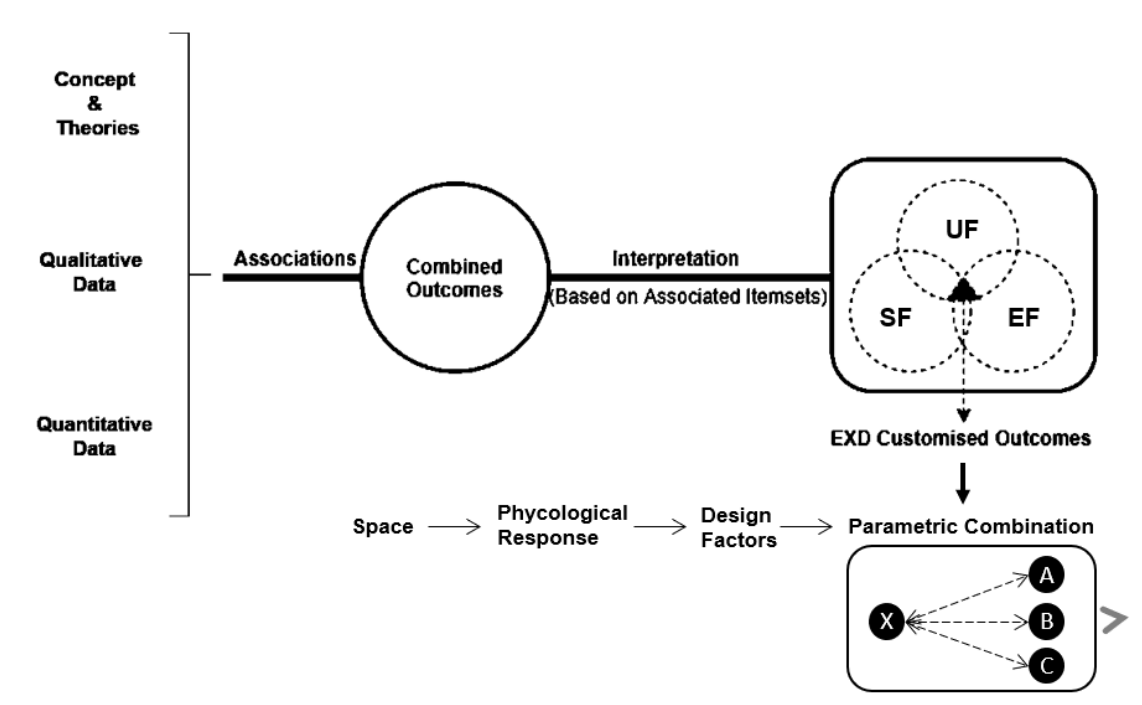
Figure 8. EXD methodological approach to customizing outcomes. (Source: author).